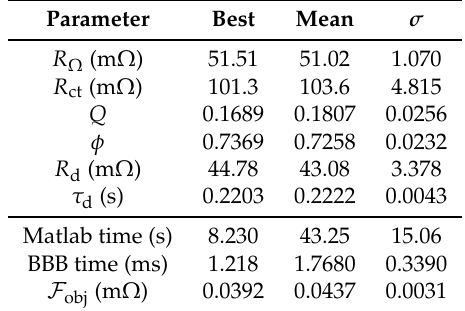
Table 4. Dataset A. EA identification results (Fouquet